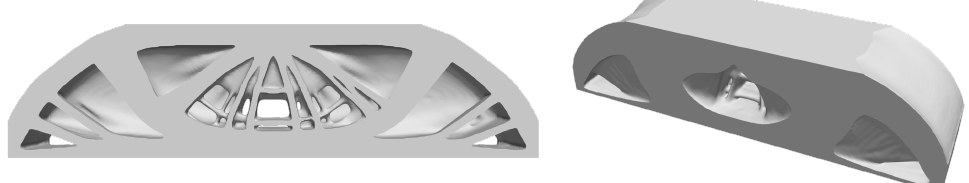
Figure 17. Derived design proposal of the standard topology optimization for optimization case 1: Sectional view ( left ) and overall view ( right